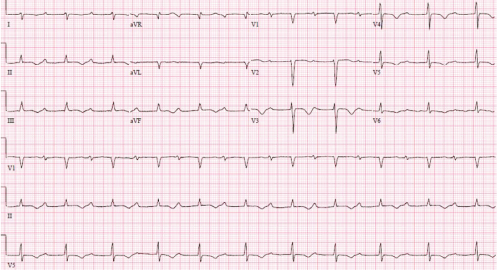
Figure 3: Profound PR